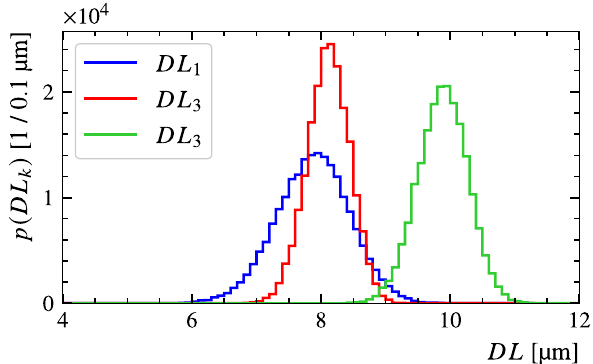
Fig. 18 Marginalised posterior distribution, p ( DL k ) , of the thickness of the dead layer at r = 12.8mm ( DL 1 ), r = 23.0mm ( DL 2 ) and r = 34.8mm ( DL 3 )